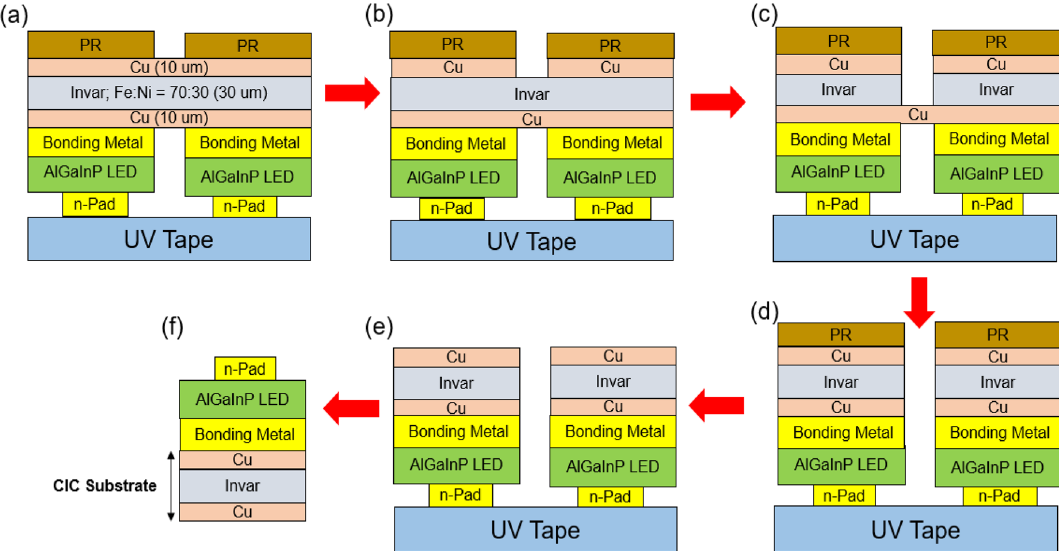
Figure 6. Process flow for the dicing of LED/CIC chips from the back side of the